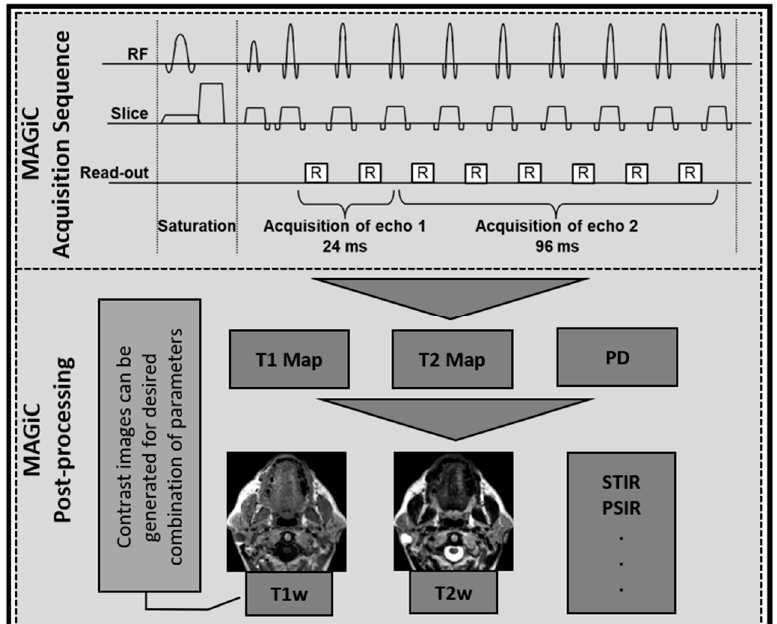
Figure 1. Synthetic MRI acquisition and post-processing: one representative block of MAGiC sequence, and MAGiC post-processing consist of generating quantitative and qualitative images. Qualitative images are generated using the relaxometry and proton density (PD) maps for the desired combination of parameters. Representative T1 and T2 images are shown, and additional contrast images can also be generated.